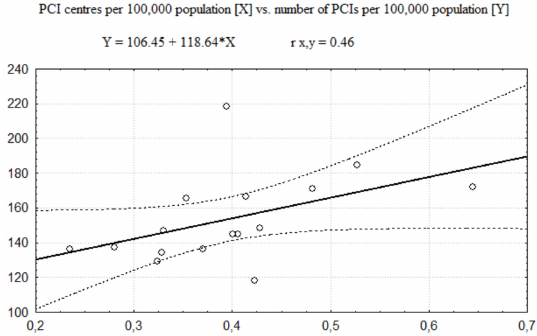
Figure 5. The regression function of PCI centres per 100,000 population vs. number of PCIs 100,000